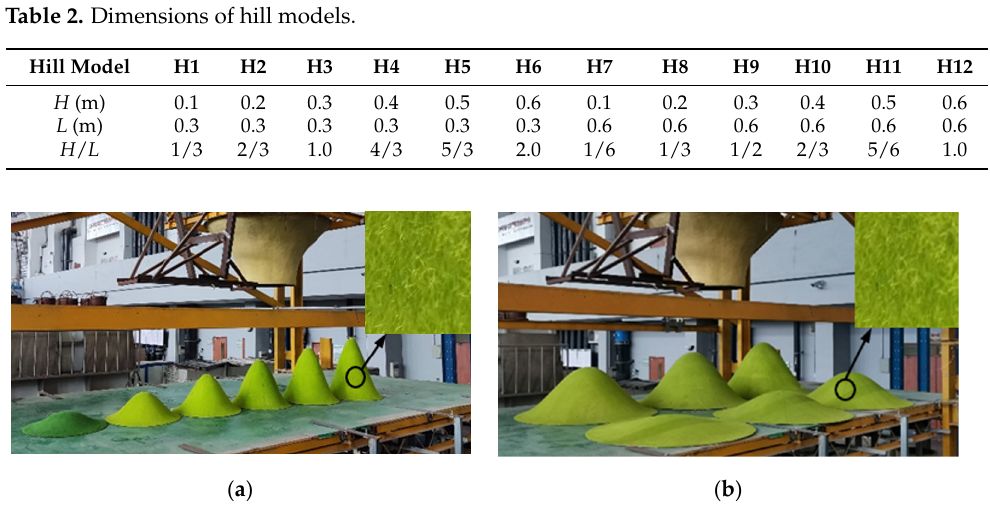
( b ) Figure 4. Layout of measuring locations and measuring points: ( a ) measuring location; ( b ) measur- ing points for measuring location of P2. To determine the jet velocity for the tests, a preliminary study on the effects of the Reynolds number (Re) was performed in advance. The Reynolds number can be com- puted according to the formula Re = V jet D / ν , where V jet is the jet velocity, D is the